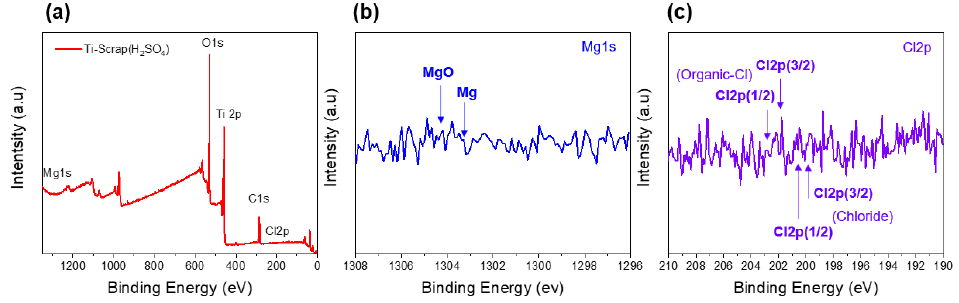
Figure 9. XPS analysis of Ti scrap by proceeding with H 2 SO 4 solution of full spectrum ( a ), magnesium ( b ), and chlorine ( c ).